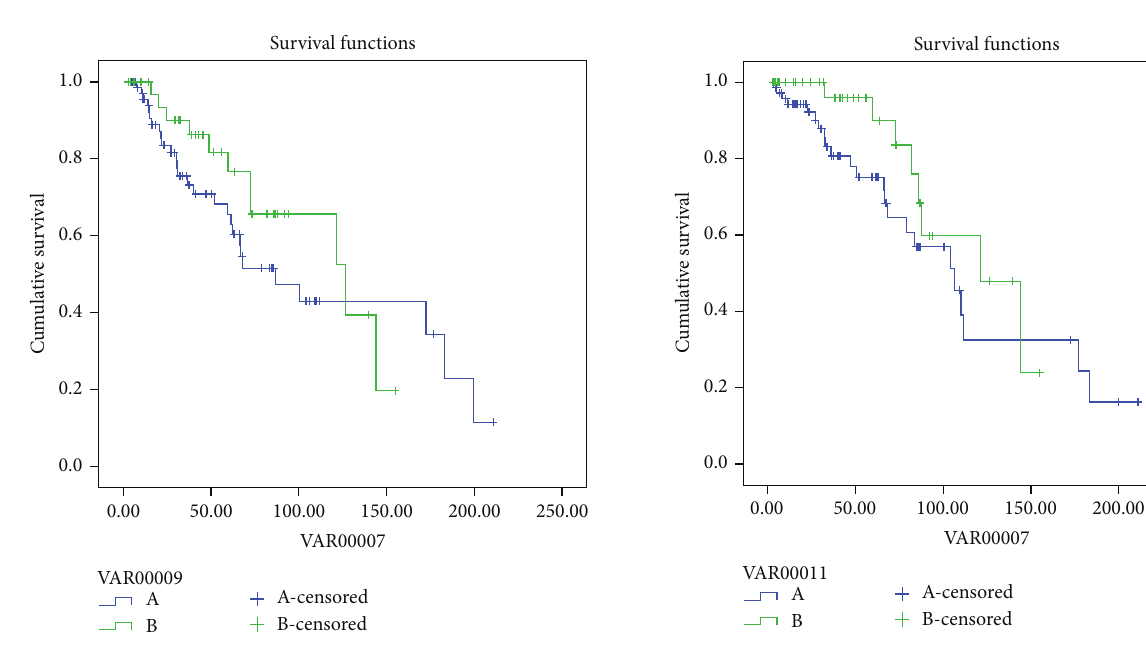
Figure 2: Technique survival PDF (green) and HDPD (blue) (log rank 𝑃 = 0.20 ).